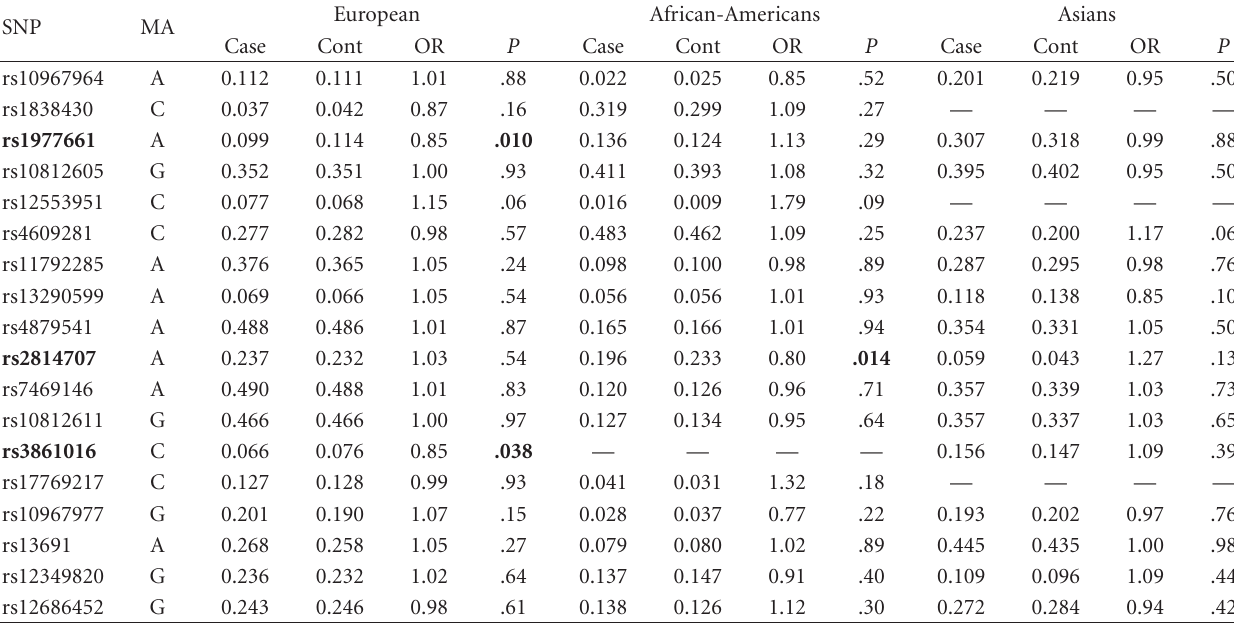
Table 3: Additive model association results from IFNK locus in each ancestral background.